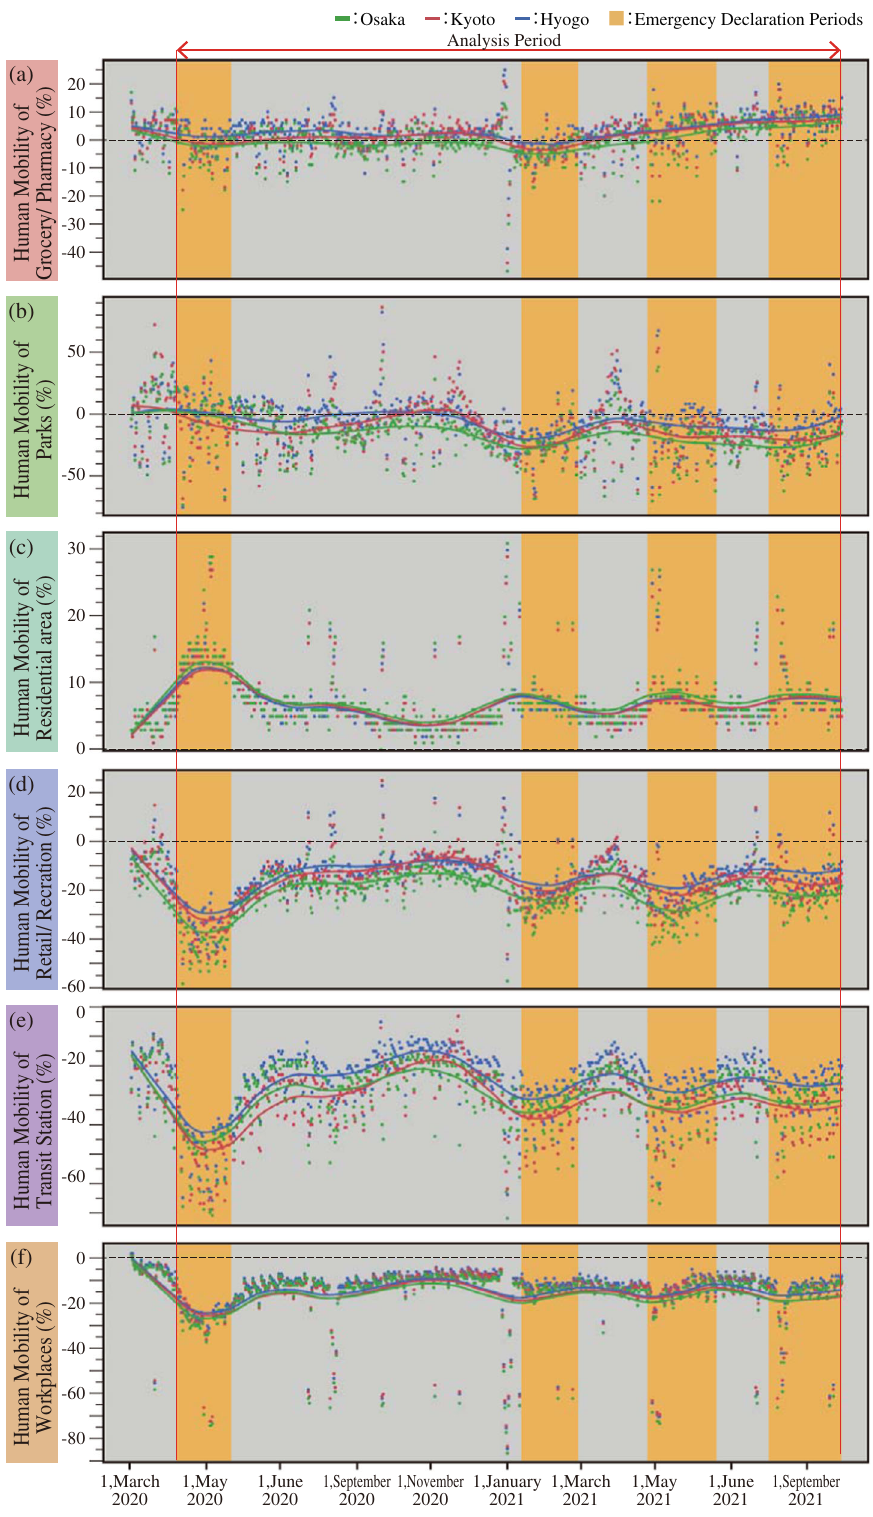
Fig. 2 Human mobility changes from March 2020 to September 2021. Human mobility types are retail/recreation ( a ), groceries/pharmacies ( b ), parks ( c ), transit stations ( d ), workplaces ( e ), and residential areas ( f ). Green points and line are the data of Osaka Prefecture, red points and line are the data of Kyoto Prefecture, and blue points and line are the data of Hyogo